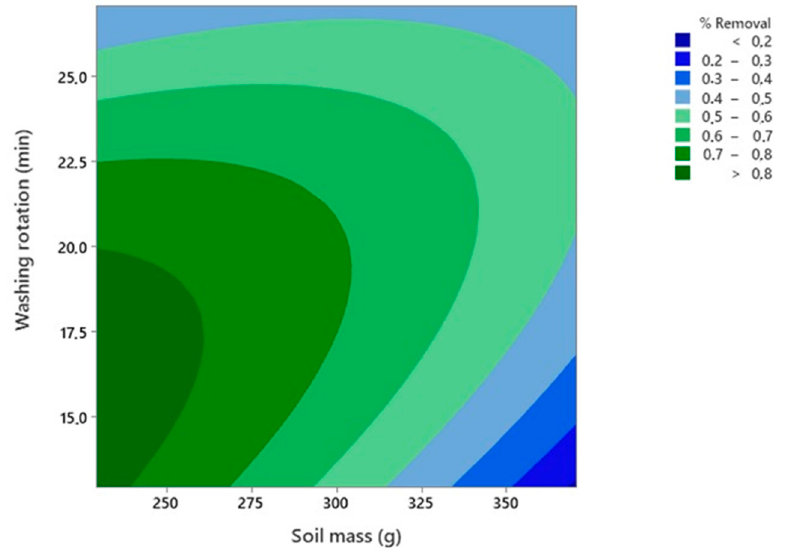
Figure 12. Contour plot of oil removal (%) vs. Washing duration (min) and Soil mass (g). The ideal composition for contaminant removal is Soil mass between 240 and 250 g and Washing duration between 15 and 20 min. Application of the RSM reveals that the composition able to optimize the removal of the contaminant from the sandy soil is 229.28 g for 15.86 min (Figure 13). For run 5 (Soil mass of 228.289 g and Washing duration of 20 min), oil removal reached its maximum value of 92.47%. Similarly, Chapr ã o et al. [40] observed the highest motor oil removals from sand using Candida sphaerica and Bacillus sp. biosurfactant crude extract (93% and 43%, respectively). It can be seen in Figure 14 that the amount of contaminant remaining in the soil after washing was lower than in the other axial runs, which suggests that this contaminant was dragged by the surfactant.